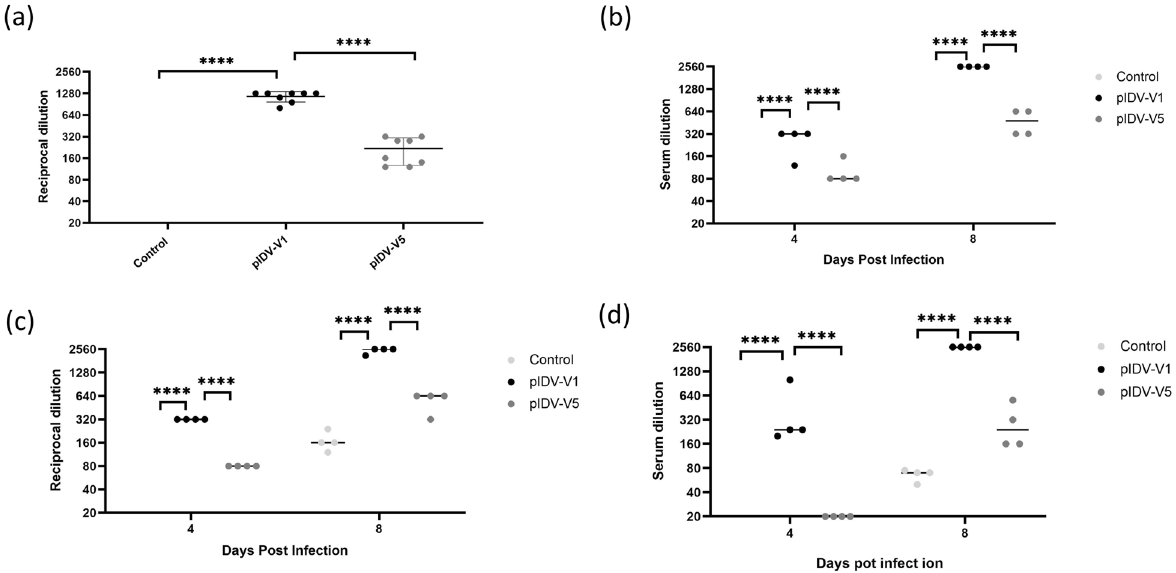
Fig. 8 Virus neutralization. a Serum neutralizing titers from hamsters vaccinated with TE buffer (control), pIDV-V1, pIDV-V5 were analysed against the SB3 (B1) isolate 4 weeks after receiving the second vaccination and prior to challenge. Titers were also evaluated at 4 and 8 dpi against b Alpha (B.1.1.7) variant and c Beta (B.1.351) as well as d SB3 (B1). Four hamsters were used per group. Two-way ANOVA with repeated measures was used for analysis, and stars denote p <